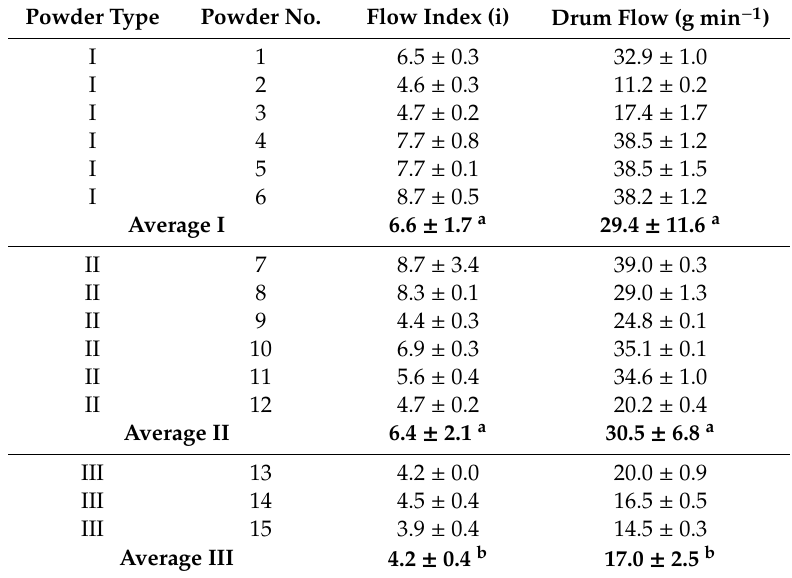
Table 4. Flowability of powders (mean of two replicates ± standard deviation). Average values presented below were calculated based on powder type ± standard